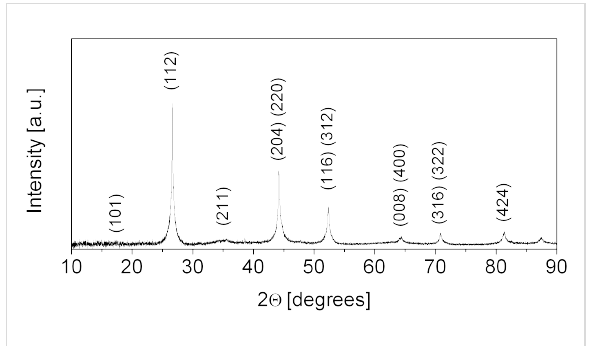
Figure 3: Powder X-ray diffraction pattern of polycrystalline CuInSe 2 nanorods after final conversion at 450